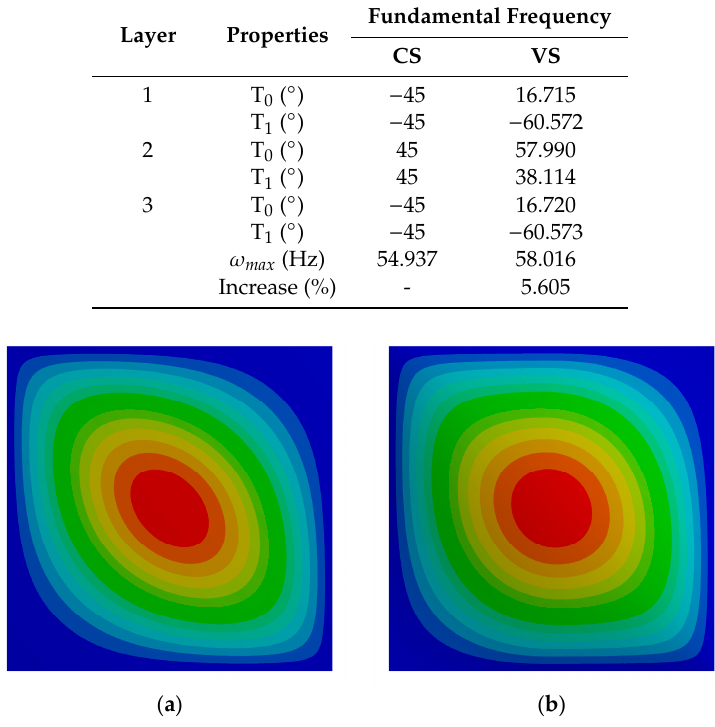
Figure 6. Fundamental vibration mode shape for the optimal layups for the SSSS plate. ( a ) CS and ( b ) VS.